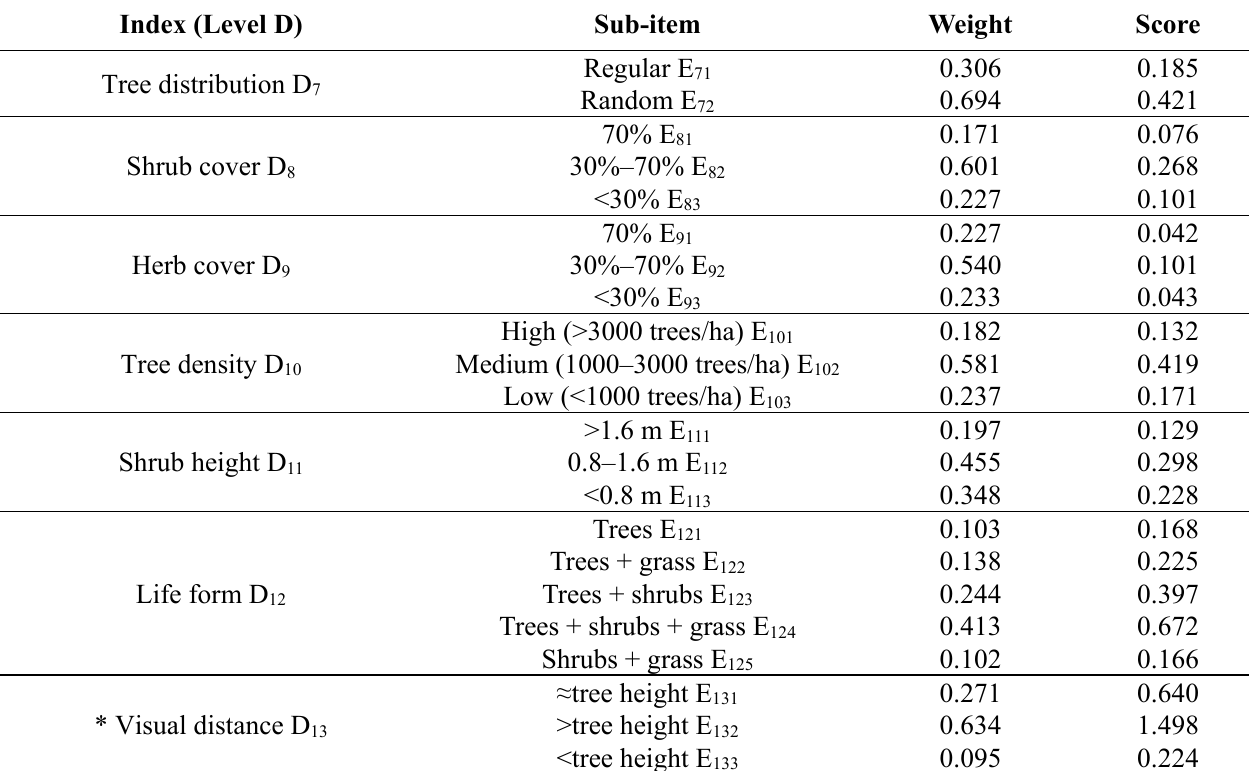
Table 4. Categories and scores of in-forest